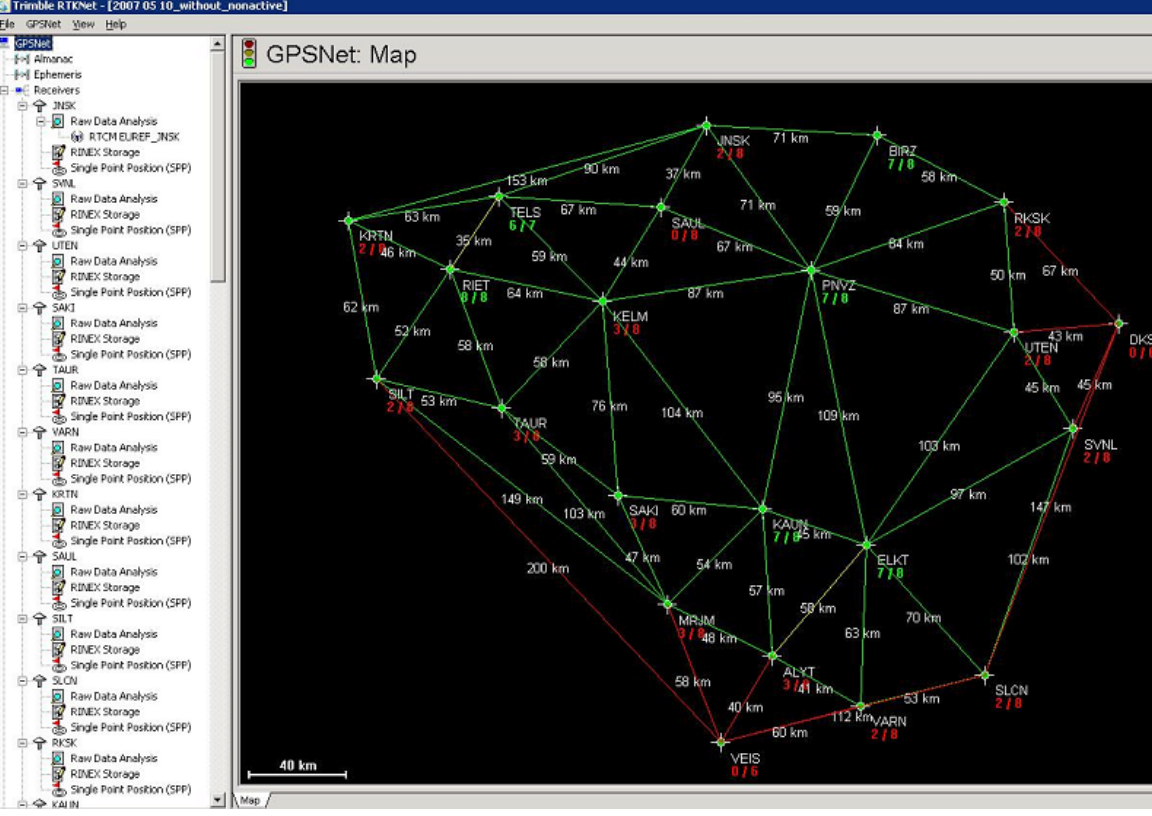
Fig. 8 . LitPOS network map in the GPSNet window